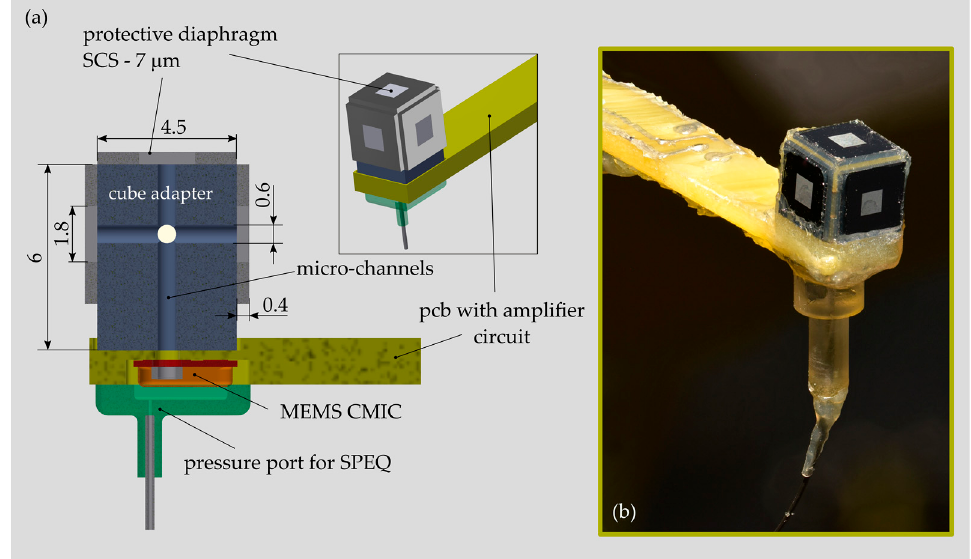
Figure 6. ( a ) Design of a multi-diaphragm intracochlear acoustic receiver (ICAR) prototype used for experimental validation of a lumped element model (LEM) representing the present packaging concept for an MEMS MIC; assembly drawing with components and dimensions and ( b ) photograph of prototype.